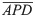
Occurrence of spiral-wave instability in a generic model of cardiac tissue with ionic heterogeneity.Variation of (a) APD¯ and (b) ω¯ (see text) with k. APD¯=APD/APDo; here, APDo is the control value of APD at g = 1 (so APD¯=1 at g = 1); we also use other combinations of (APD¯, g) in our numerical simulations. We find that APD¯ decreases with increasing k; however, ω¯ increases with increasing k. (c) Pseudocolor plots of V, at three representative times (time increases from left to right), illustrating the development of the spiral-wave instability in the Aliev-Panfilov model with a linear gradient in k; S1 Video in SI shows the complete spatiotemporal evolution of this instability.